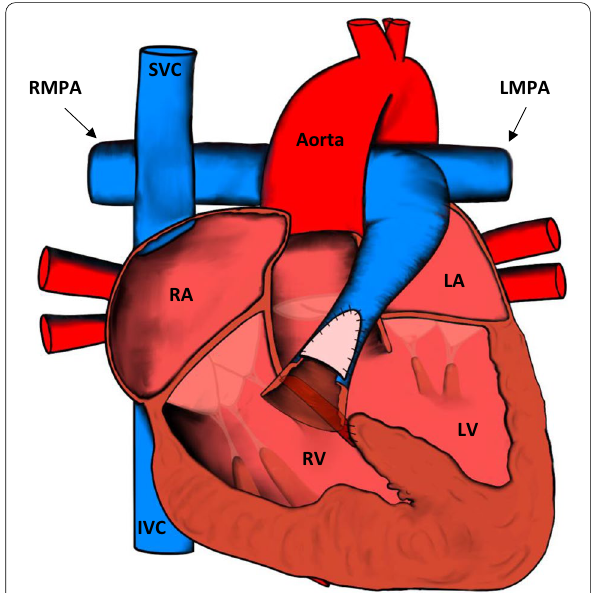
Fig. 1 Appearances of the heart after TOF repair. The RVOT is repaired and the VSD is closed. IVC: inferior vena cava; LA: left atrium; LV: left ventricle; LMPA: left main pulmonary artery; RMPA: right main pulmonary artery; RA: right atrium; RV: right ventricle; SVC: superior vena